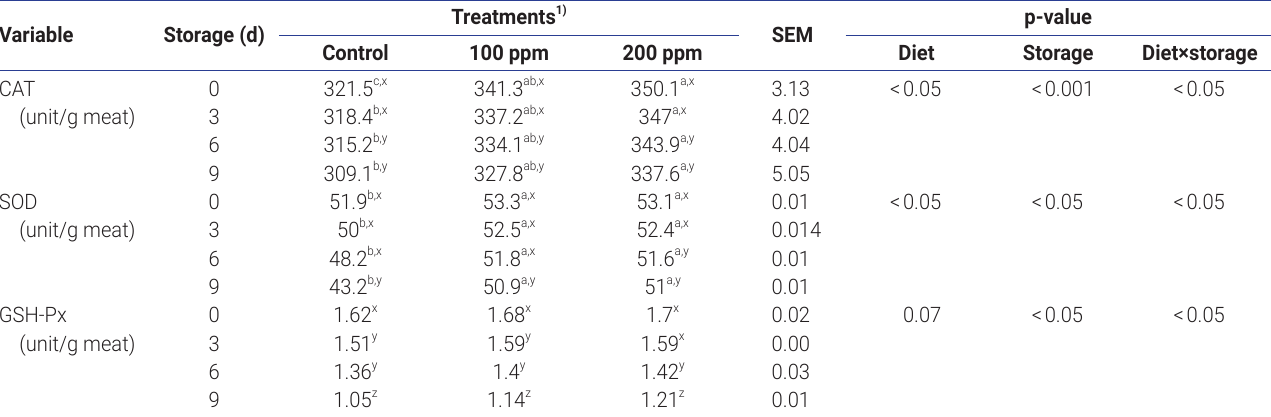
Table 4. Effect of rumen protected γ-aminobutyric acid supplementation on antioxidant enzymes of longissimus lumborum from Hanwoo steers during refrigerated storage